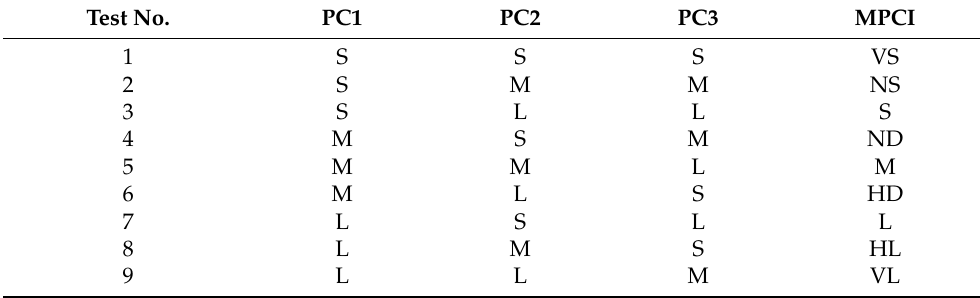
Table 5. Fuzzy rules for the input and output of the receiver structures.